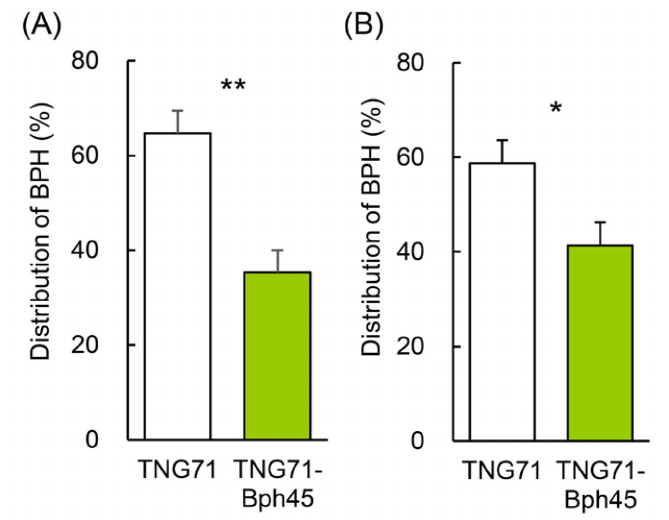
Figure 2. The settling preference of BPH examined using a Y-maze olfactometer. BPHs were released in a Y-maze tube with air supplied through containers containing 10 TNG71 or TNG71- Bph45 rice plants, which were ( A ) not previously invaded and ( B ) previously invaded by 300 BPHs for 3 days. The percentage of BPHs that moved to each side of the trap was calculated 2 days after release.